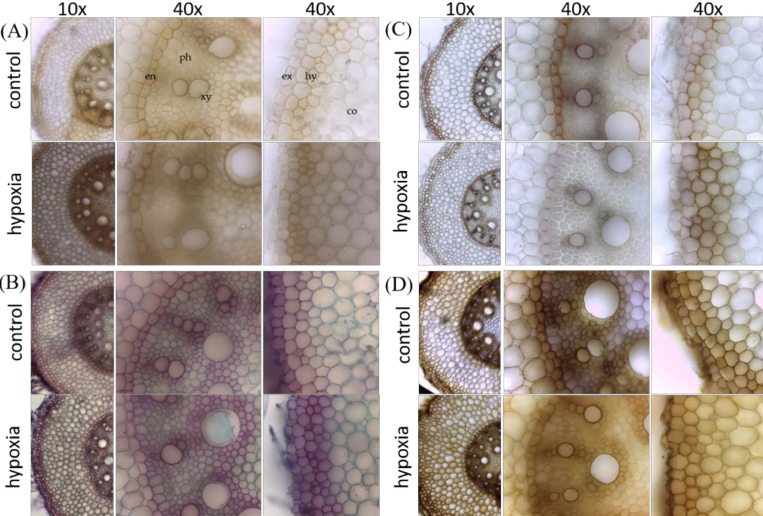
Figure 7. Visualization of lignin, its precursors, and cellulose in the mature zone of primary root cross-sections from control and hypoxia-stressed maize plants. Control and 24 h hypoxia-stressed maize roots were cross-sectioned by hand and analyzed with ( A ) Mäule staining for syringyl-rich polyphenols (deep-red color), ( B ) fuchsin, chrysoidin, and Astra blue (FCA) staining for lignified cells (red color) and non-ligneous cells (blue color), ( C ) Phloroglucinol staining for lignified cells (pink color), and ( D ) chlorine–zinc–iodine staining for cellulose (violet color). For detailed explanation of the colours, see methods. Co, cortex; en, endodermis; ex, exodermis; hy, hypodermis; ph, phloem; xy,